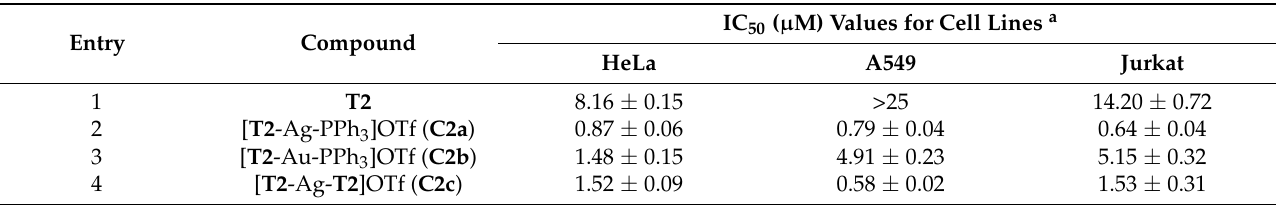
Table 3. Antitumor activity of complexes C2a–c expressed in IC 50 values compared with that of thiourea T2 as